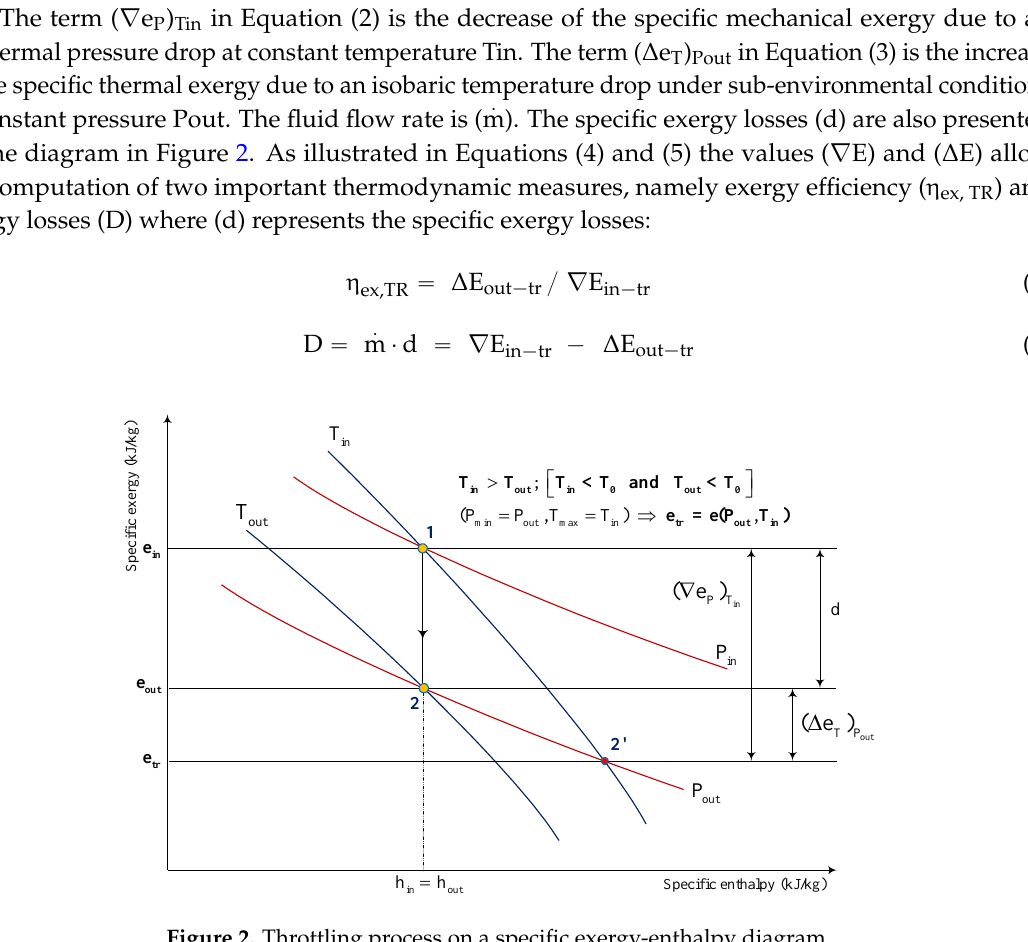
Figure 2. Throttling process on a specific exergy-enthalpy diagram.